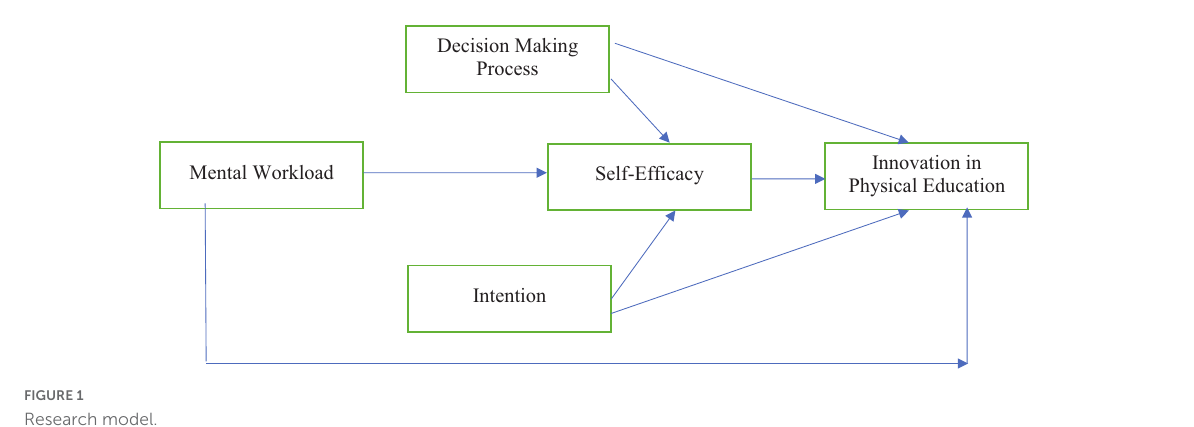
FIGURE1 Research